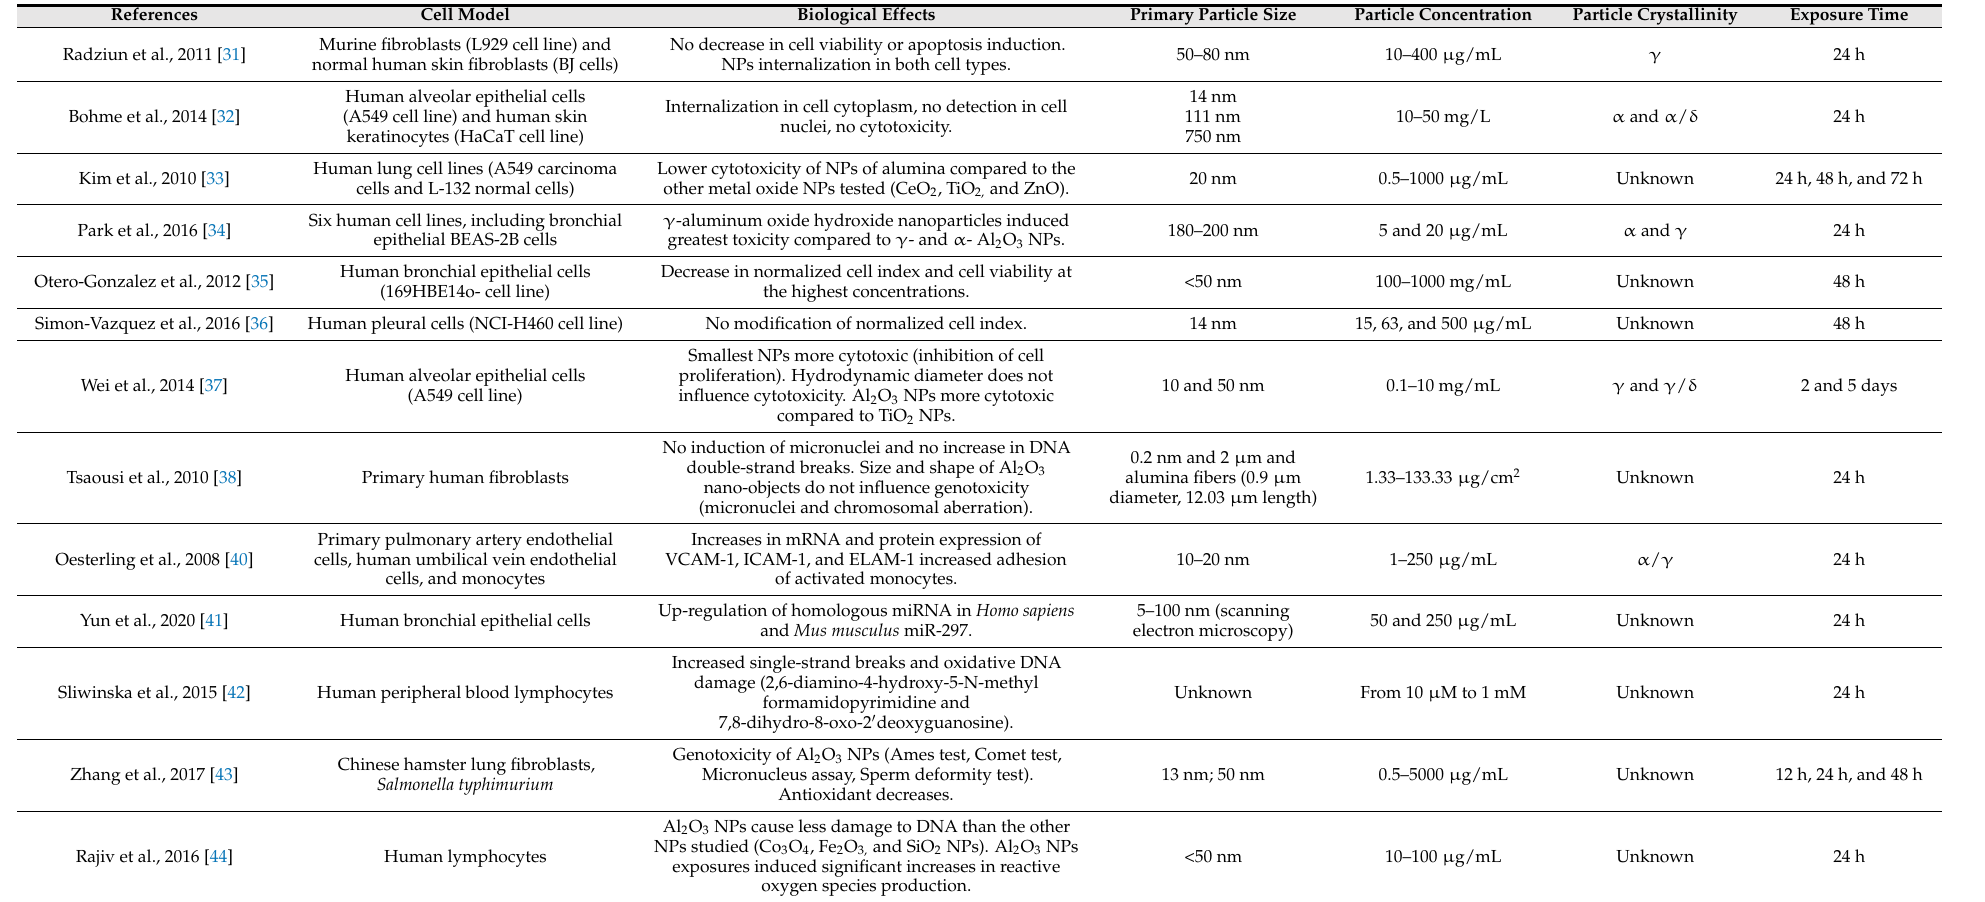
Table 3. Summary of in vitro